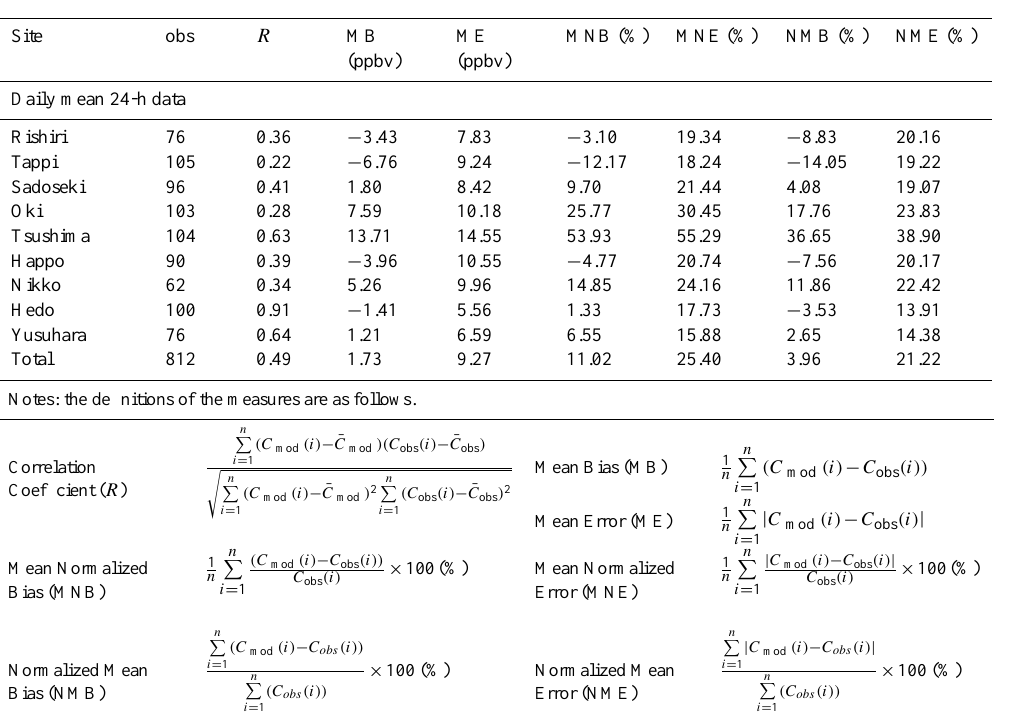
Table 7. Statistical measures for model performance evaluation for O 3 for the year 2000.